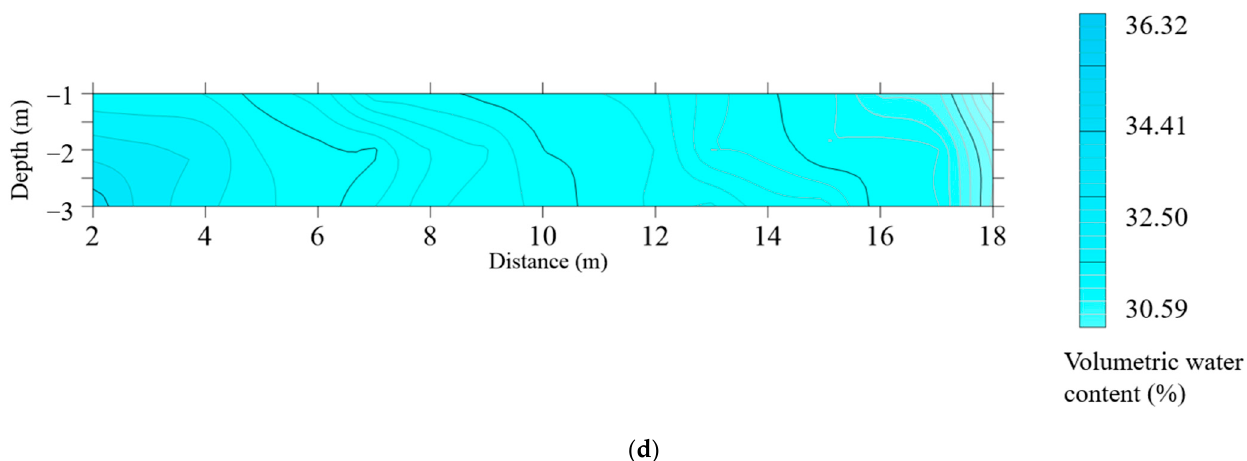
Figure 20. Distribution of the moisture contents of different measuring lines: ( a ) survey line 1; ( b ) survey line 2; ( c ) survey line 3; ( d ) survey line 4.